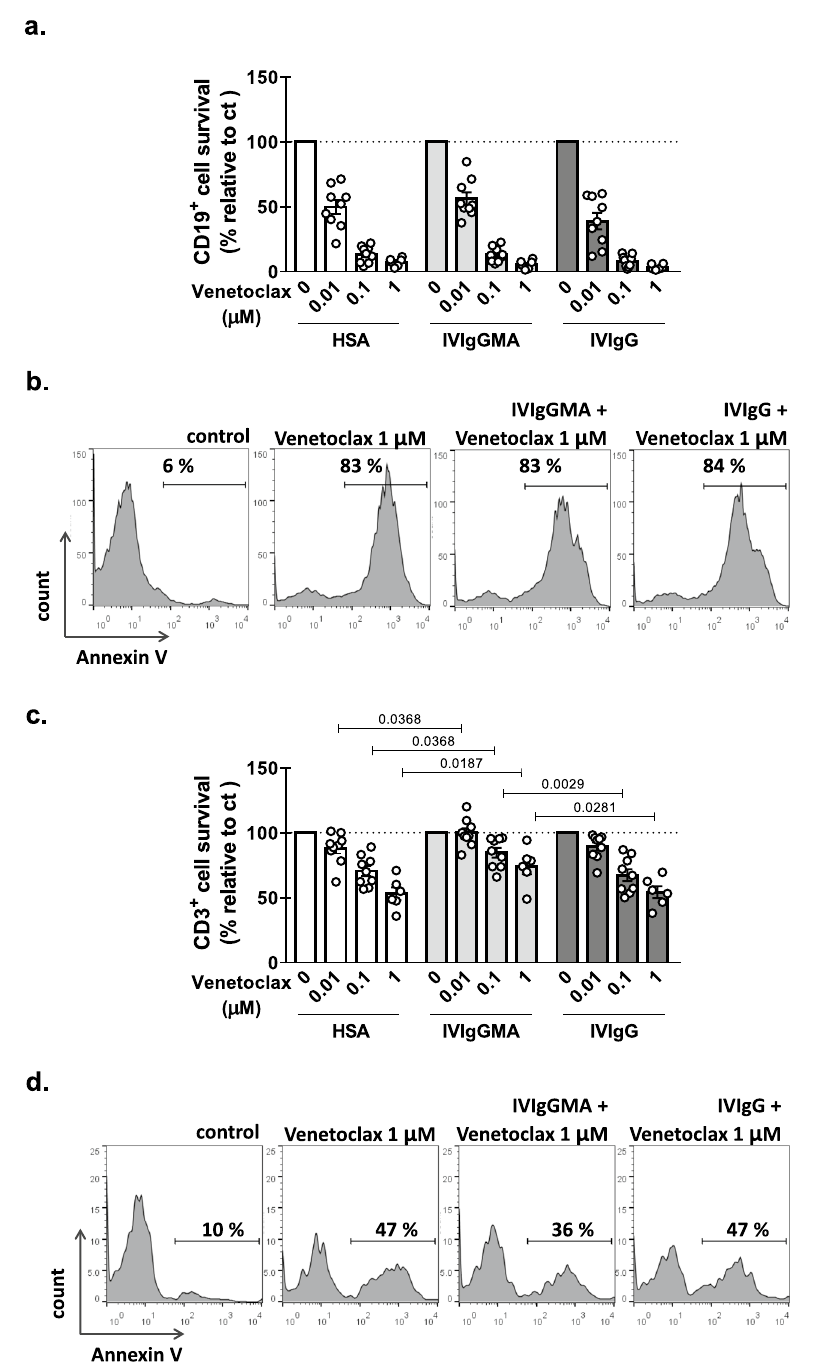
Figure 5. Effect of IVIg preparations on T and B cell apoptosis induced by the BCL-2 inhibitor, venetoclax. PBMC from CLL patients were cultured with IVIgGMA, IVIgG (10 mg/mL of IgG) or HSA. Then, different doses of venetoclax or DMSO (ct) were added to cultures. After 24 h of culture, cell viability was assessed by flow cytometric alterations of light scattering properties and confirmed by staining with Annexin V. ( a ) Percentage of CD19 + viable cells. Results are shown as the percentage of viable cells in each condition relative to its control condition. Individual values and the mean ± SEM are shown. ( b ) Representative histograms of Annexin V staining in CD19 + cell population are shown. ( c ) Percentage of CD3 + viable cell. Results are shown as the percentage of viable cells in each condition relative to its control condition. Individual values and the mean ± SEM are shown. ( d ) Representative histograms of Annexin V staining in CD3 + cell population are shown. Statistical analysis was performed using Friedman test followed by Dunn’s post-test. Significant p values are shown in the graph. n = 9, p < 0.05 was considered